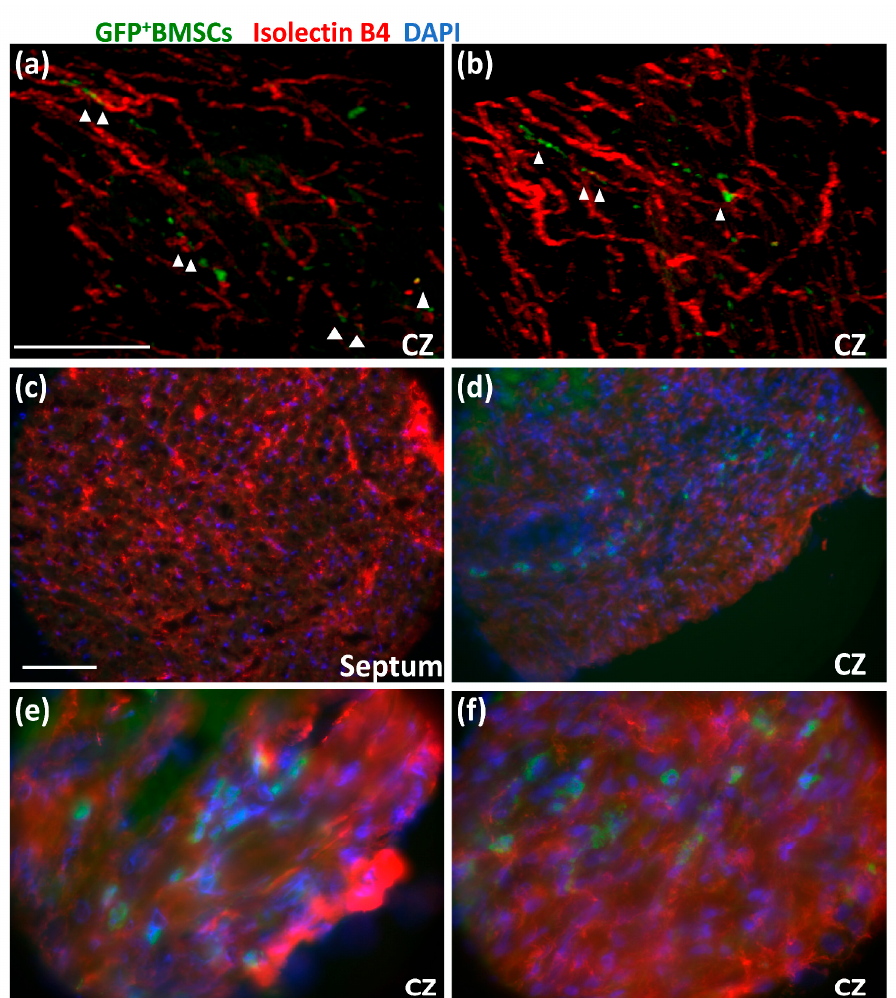
Figure 3. Bone marrow-derived stem cells (BMSCs) engrafted in blood vessels in the collateral dependent zone (CZ) of chimeric rats with GFP + BM during repetitive ischemia (RI) protocol. ( a , b ). Multi-photon images of CZ of chimeric rat heart. Arrowheads indicate the colocalization of GFP + BMSCs with EC marker isolectin-B4. The scale bar equals 100 µ m. ( c , d ). Confocal images of sections of the septum ( c ) and CZ ( d ) of chimeric rat heart. The scale bar equals 100 µ m. ( e , f ) are high magnification images of ( d ), showing that GFP + BMSCs were recruited to the CZ and differentiated into endothelial cells (EC) during coronary collateral growth induced by RI. Green shows GFP + BMSCs. Red indicates the EC marker (isolectin-B4). Blue shows nuclei.